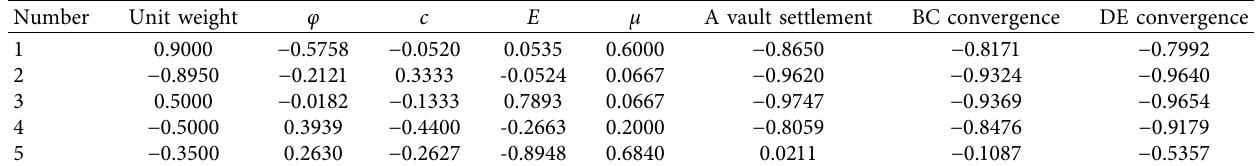
Table 5: The normalized testing